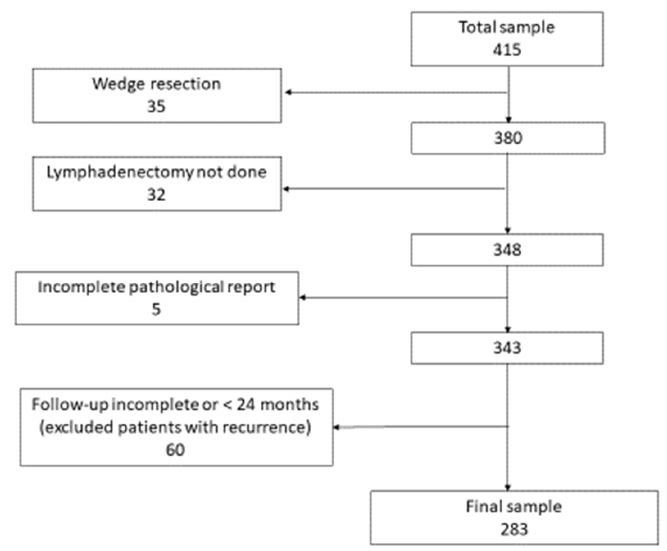
Figure 1. Flow chart showing patient selection for the study. Table 2. Clinical and pathological characteristics.